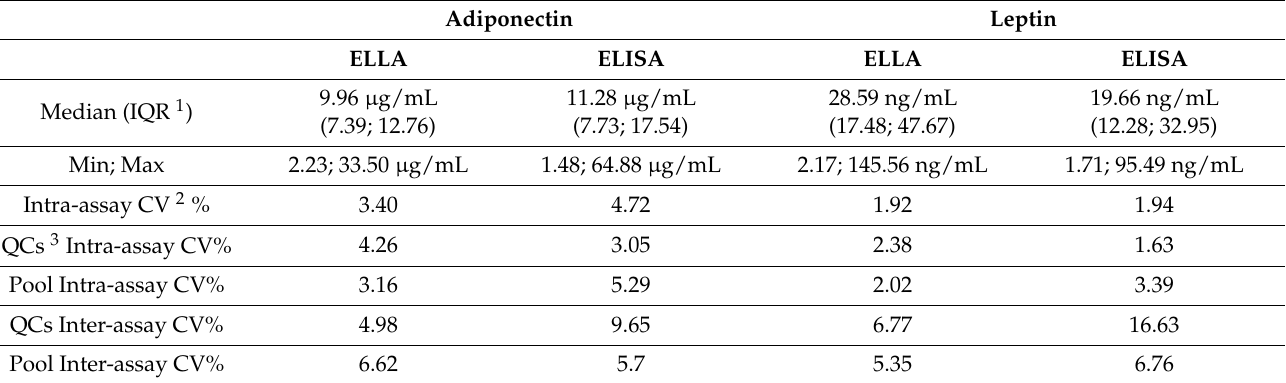
Table 2. Adiponectin and leptin values, intra- and inter-assay precision by method. Adiponectin Leptin ELLA ELISA